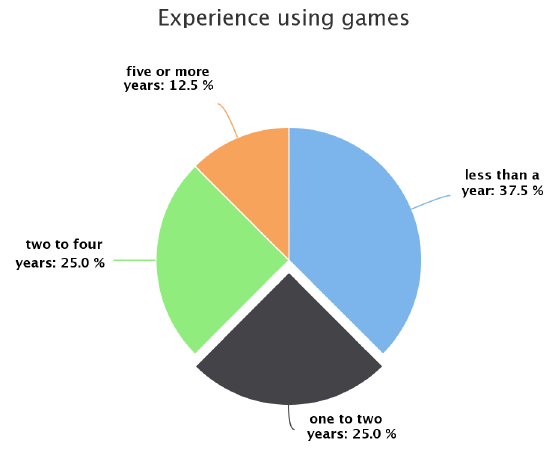
Figure 4: Experience of the physiotherapists using games during re- habilitation processes